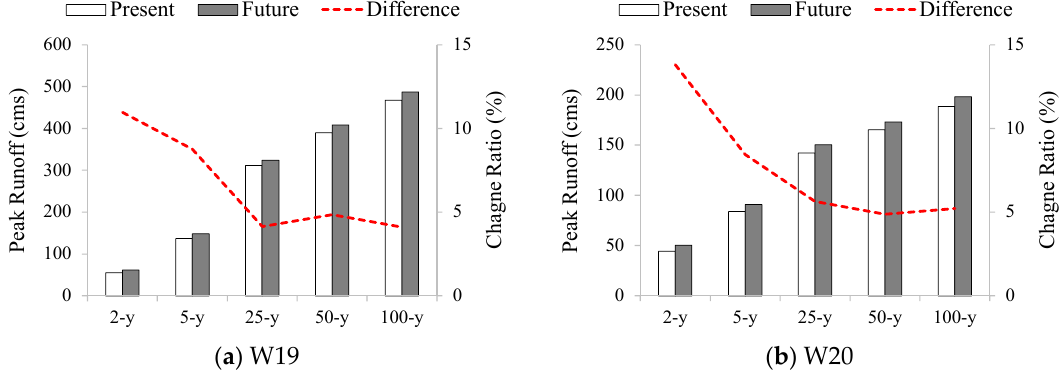
Figure 4. Present and future runoff peaks on watershed scale for ( a ) W19 and ( b ) W20.